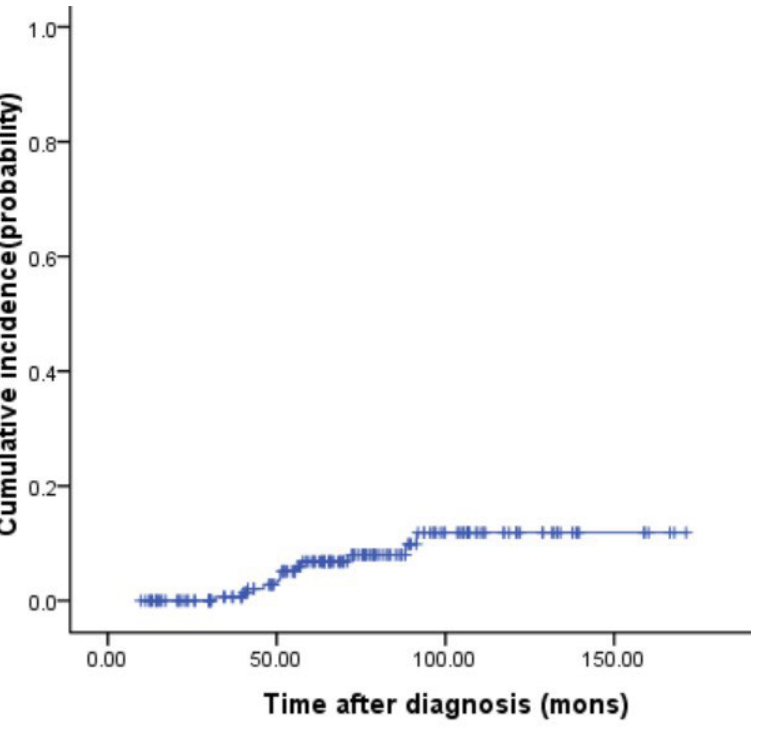
Figure 1. Cumulative incidence rates of sALL in 179 multiple myeloma patients.